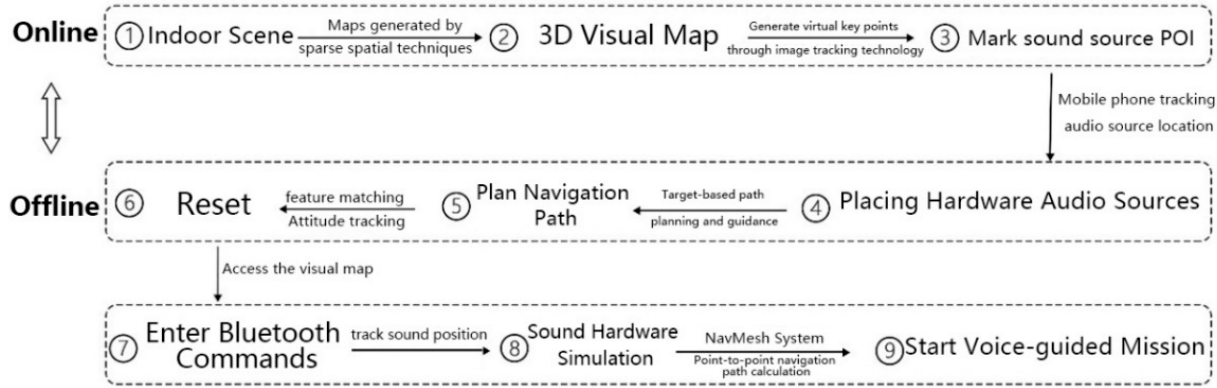
Figure 4. Design concept drawing of orientation aids. Figure 3. Scene diagram of the use of mobile audio accessories.